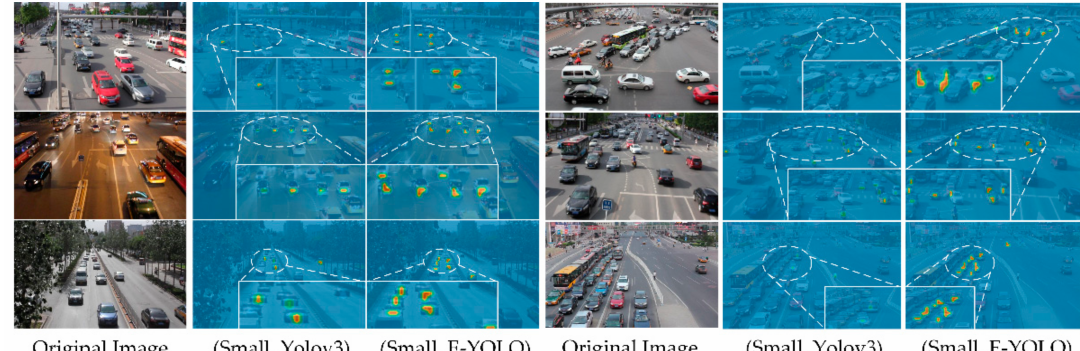
Figure 8. The activation ranks of the objectiveness of two models in the small-scale vehicles. Pictures in the second column of each scene are the activation ranks of traditional YOLOv3, and the third column is the ones of E-YOLO. Objects are identified with different colors in different objectiveness ranks. The colors from light blue to orange-red are defined as the confidence from zero to one by indexing the confidence rank in HTML Color Table. Best viewed on screen.